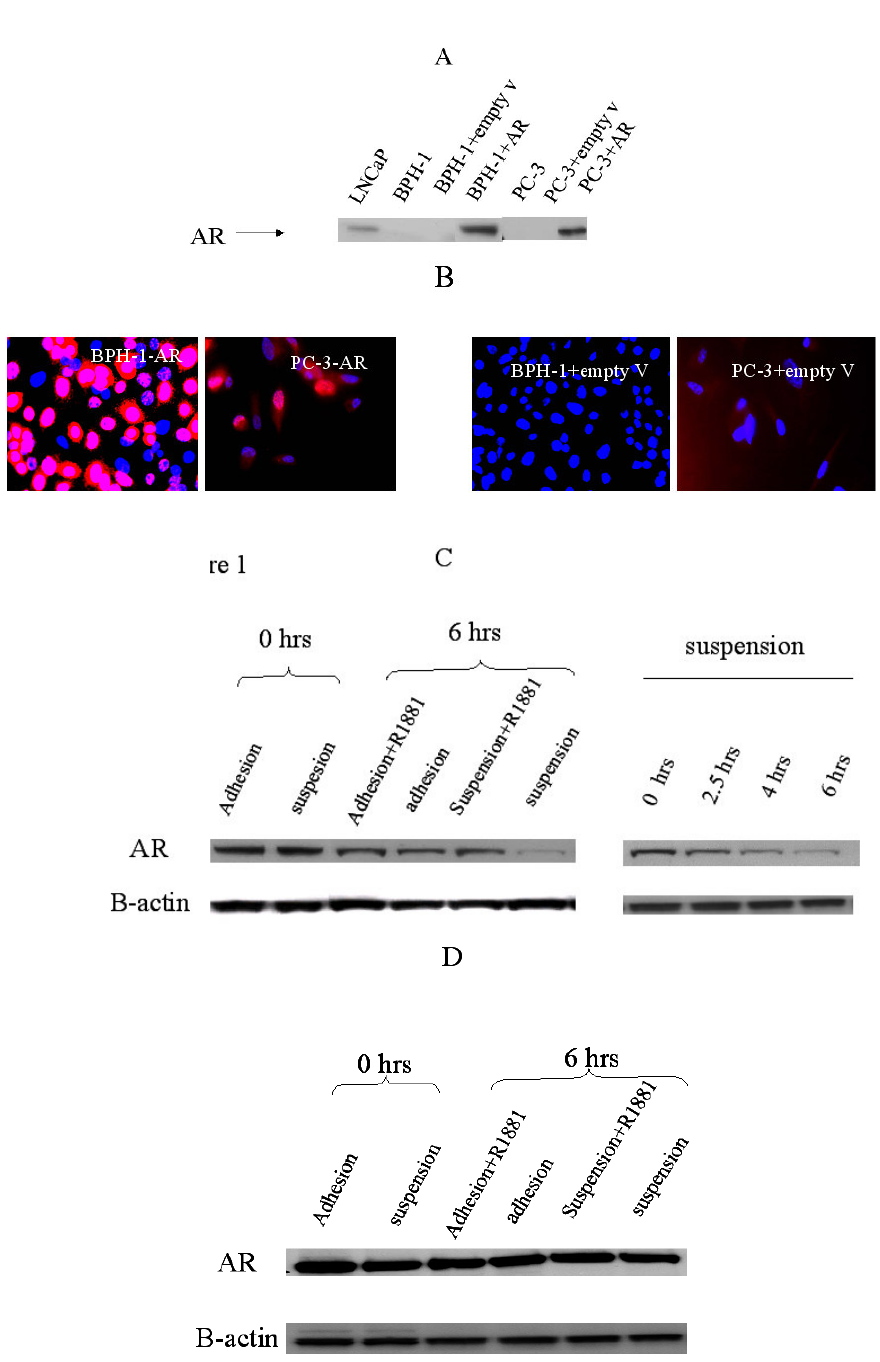
Figure 1. A. BPH-1 and PC-3 cells highly express AR after infection showed by western blot. Western blot of whole cell lysate were probed with anti-AR antibody. Lane 1 is LNCaP cell as positive control , and lane 2-7 are BPH-1, BPH-1 infected with empty vector, BPH-1infected with AR vector, PC –3 , PC-3 infected with empty vector, and PC-3 infected with AR vector, respectively. B BPH-1 and PC-3 highly express AR after infection showed by immunofluorescent analysis. BPH-1 and PC-3 cells were adherent onto coverslips and incubated for overnight. Cell were fixed and stained with anti-AR antibody. More than 80% of BPH-1 and PC-3 cells expresse AR after infection(left). Empty Pbape vector infection was used for the negative control in this experiment(right). 400X magnification. C Adhesion effect on AR expression in BPH-1-AR cells(left). BPH-1 cells were cultured in charcoal-stripped FCS for at least 48 hours before the experiment. Cells adhering or kept in suspension, treated with R1881 or not were harvested at time point 0 and 6 hours. Western blot of 50 ug cell lysate per lane was probed with mouse anti-AR antibody. The gel was also re-probed with anti-b- actin antibody. A time-course study of BPH-1-AR cell in suspension was also conducted(right). D Adhesion effect on AR expression in PC-3-AR cells. Similar with BPH-1-AR cells, adherent or suspended cells either treated with R1881 or not were harvested at time point 0 and 6 hours followed by Western blot for AR